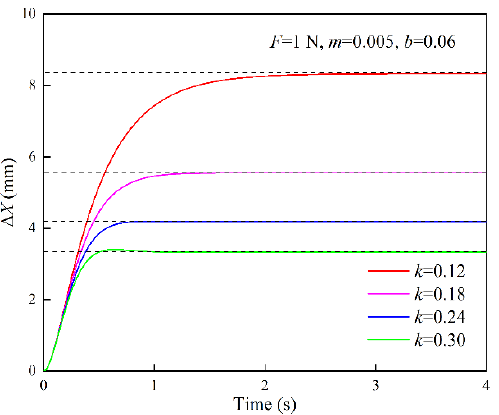
Figure 6. Response curves of position correction amount under different stiffness parameters ( m :